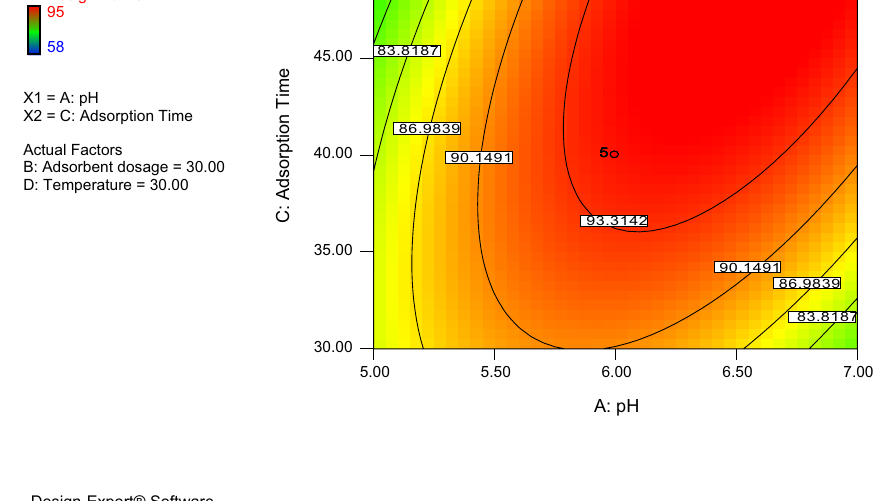
Fig. 7 3D plot showing the effect of adsorbent dosage and adsorption time on adsorption efficiency in the treatment of fibre cement industry